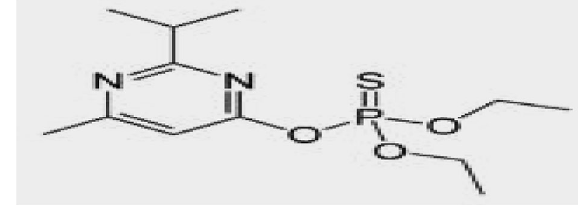
Fig. 1 Chemical formula of the